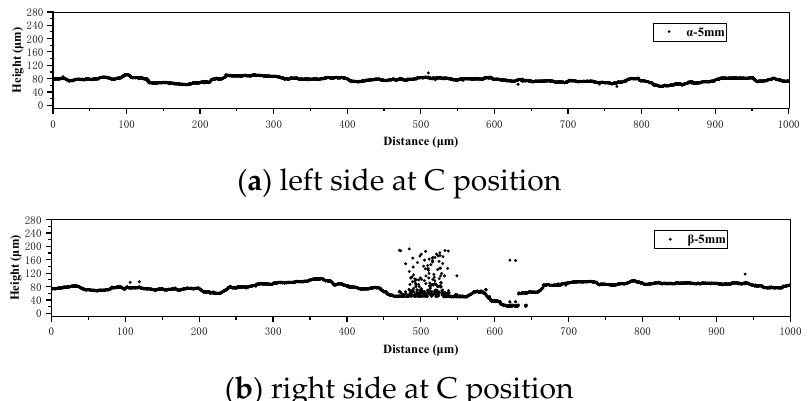
Figure 8. The etched surface heights ( h es ) of the left side ( α ) and right side ( β ) at C position (5 mm to bloom edge) in the inner curve side under 20 °C superheat: ( a ) left side, ( b ) right side. (The measuring length of each side is 1.0 mm, and there are 1001 points with 0.25 µ m intervals along the distance).